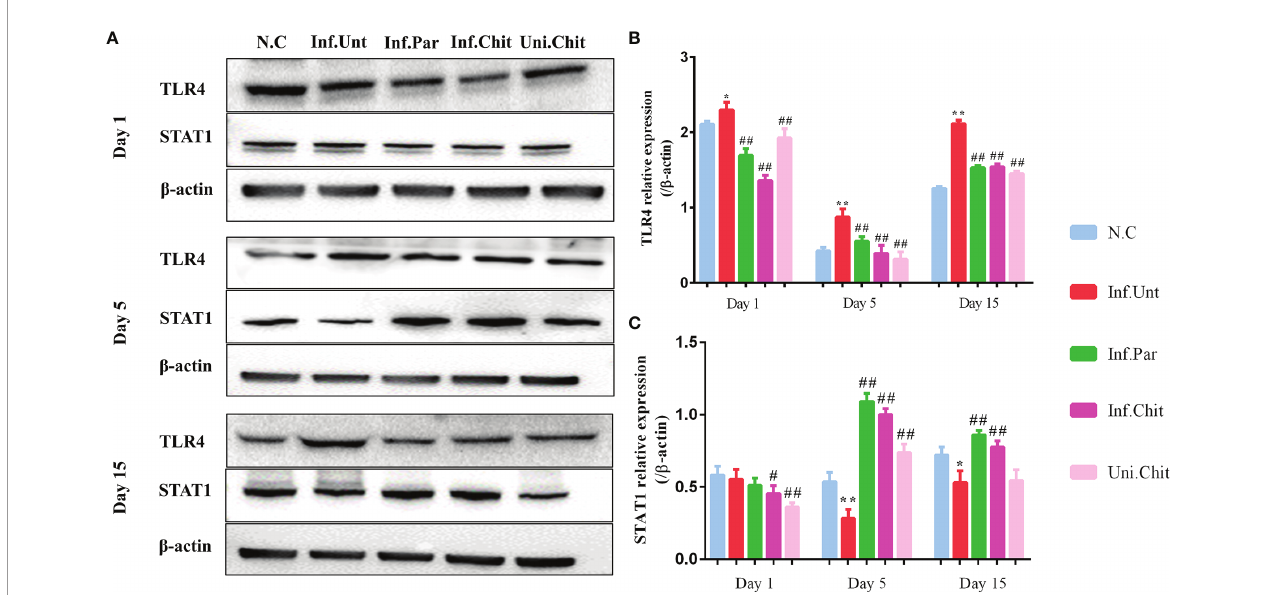
FIGURE 3 | Effects of chitosan on the induction of the TLR4 and STAT1 signaling pathways. (A) Western blot detection of TLR4 and STAT1 expression in intestinal tissues. (B, C) The relative expression of TLR4 and STAT1 protein in each group. All values are indicated as the mean ± SEM of three independent tests. * and ** indicate signi fi cant differences at p < 0.05 and p < 0.01, Inf.Unt group compared with N.C group; # and ## indicate signi fi cant differences at p < 0.05 and p < 0.01, Inf.Unt group compared with Inf.Par, Inf.Chit, and Uni.Chit groups. The experiment was repeated three times with similar